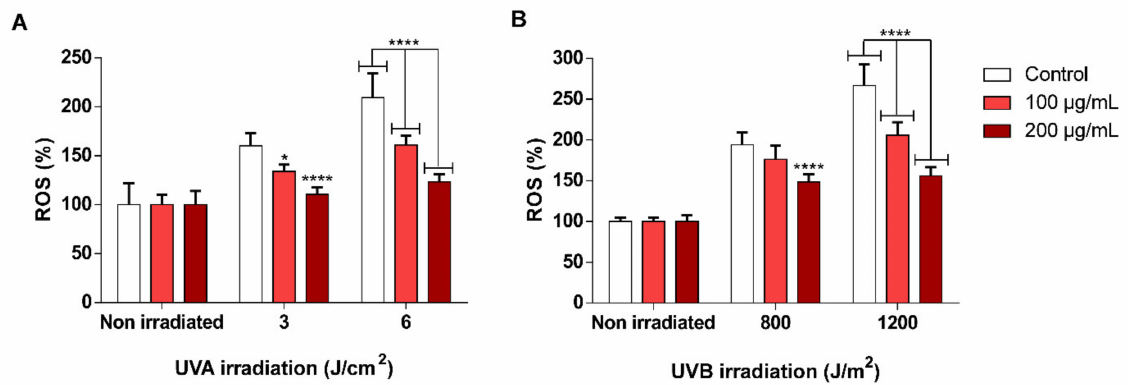
Figure 4. Determination of the antioxidant e ff ects of scSFE related to UVA- ( A ) and UVB- ( B ) induced reactiveoxygen species (ROS) generationin HaCaT cells. Fluorescencewas normalized to non-irradiated controls. The white bars indicate the fluorescence signal in the absence of treatment for each condition. The data are expressed as the mean ± SD ( n = 6). * ( p < 0.05) and **** ( p < 0.0001) indicate significant di ff erences compared with irradiated cells at the same UVA dose (3 or 6 J / cm 2 ) or UVB dose (800 or 1200 J / m 2 ) in the absence of